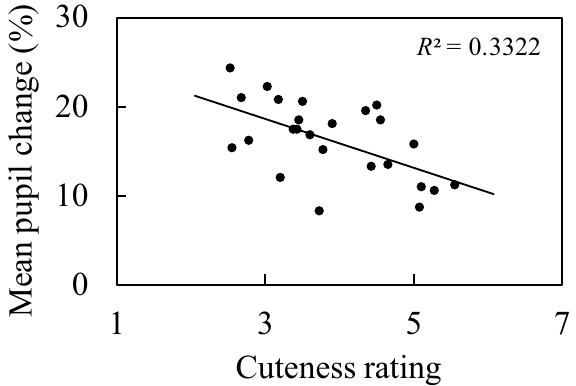
Figure 6. The correlation between the cuteness of the facial images and the mean pupil change. The value in the upper right corner of the panel is the coefficient of determination.